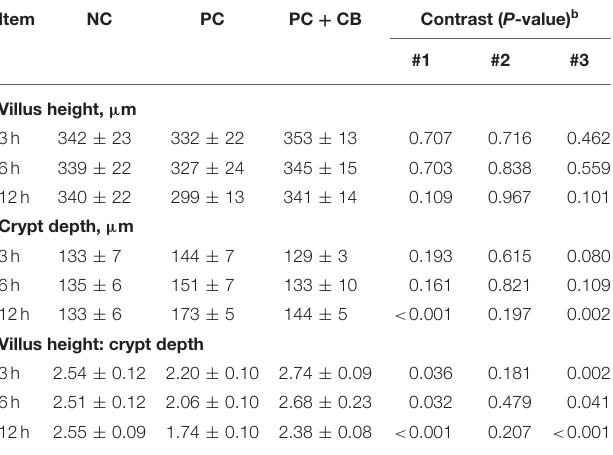
TABLE 7 | Effect of CB on intestinal morphology of piglet jejunum a